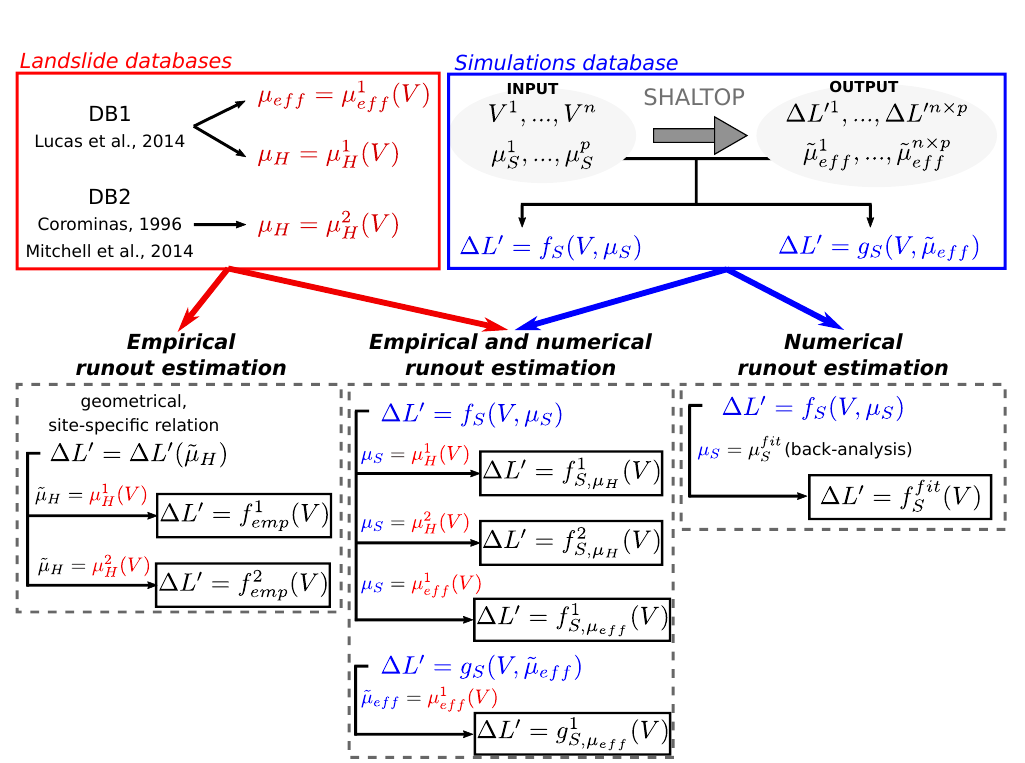
Figure 6. Methodologies to derive volume dependent relations for travel distance estimation. The superscripts 1 and 2 refer to the empirical database that is used for a given relation ( DB1 and DB2 , respectively). In this study, all functionals are power